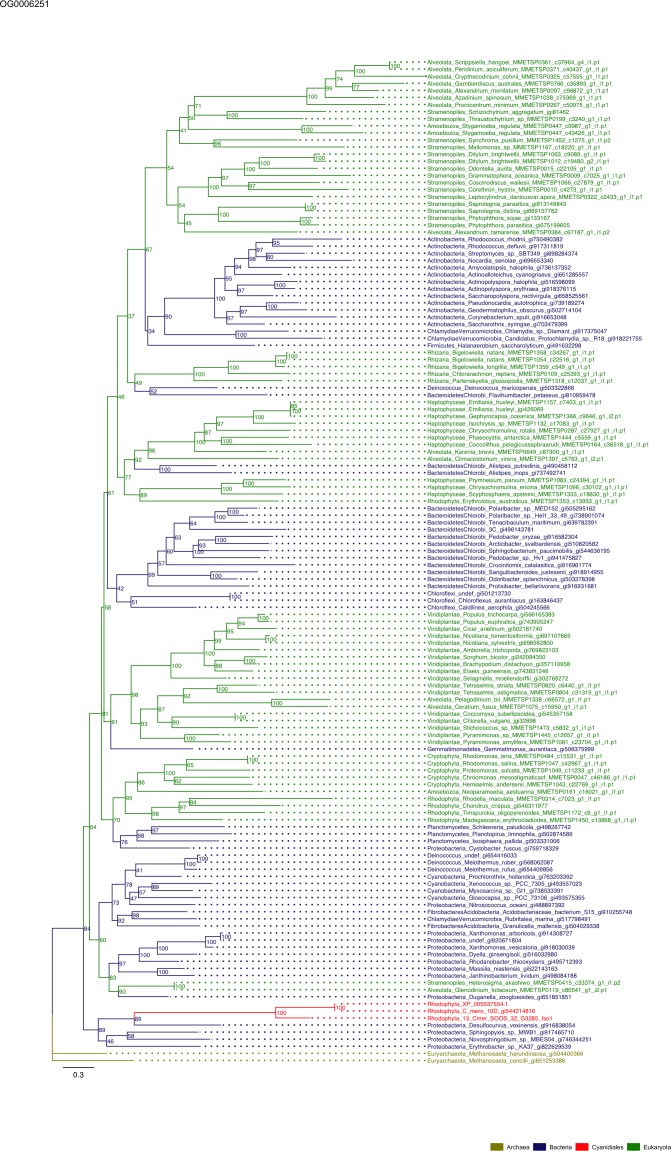
Sequence tree of orthogroup OG0006251.The tree is based on amino acid sequences. Archaea (yellow), Bacteria (blue), Cyanidiales (red), Eukaryotes including other red algae (green). Branches containing Cyanidiales sequences are highlited in red.